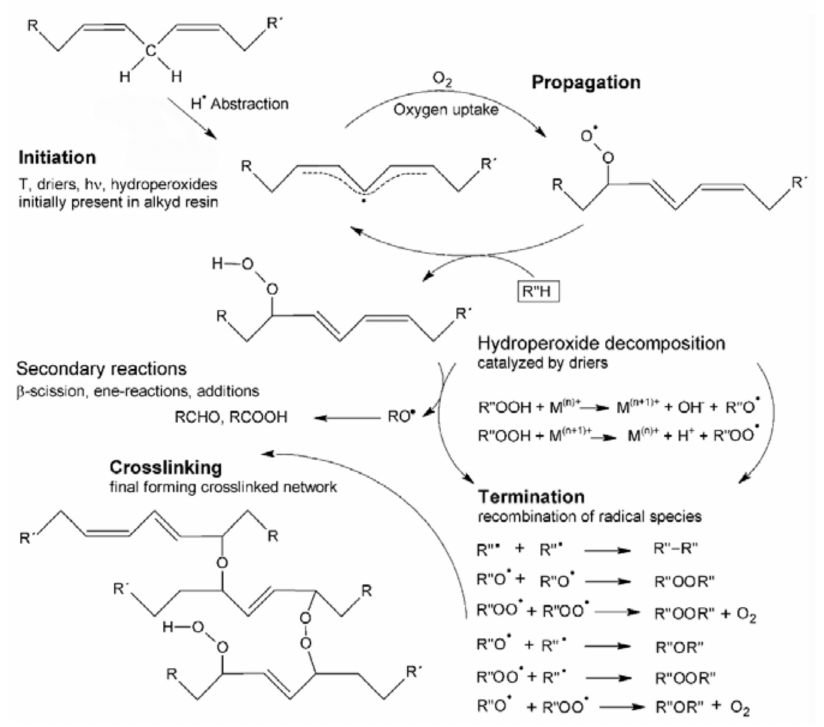
Figure 1. Simplified mechanism of autoxidation process accelerated by primary